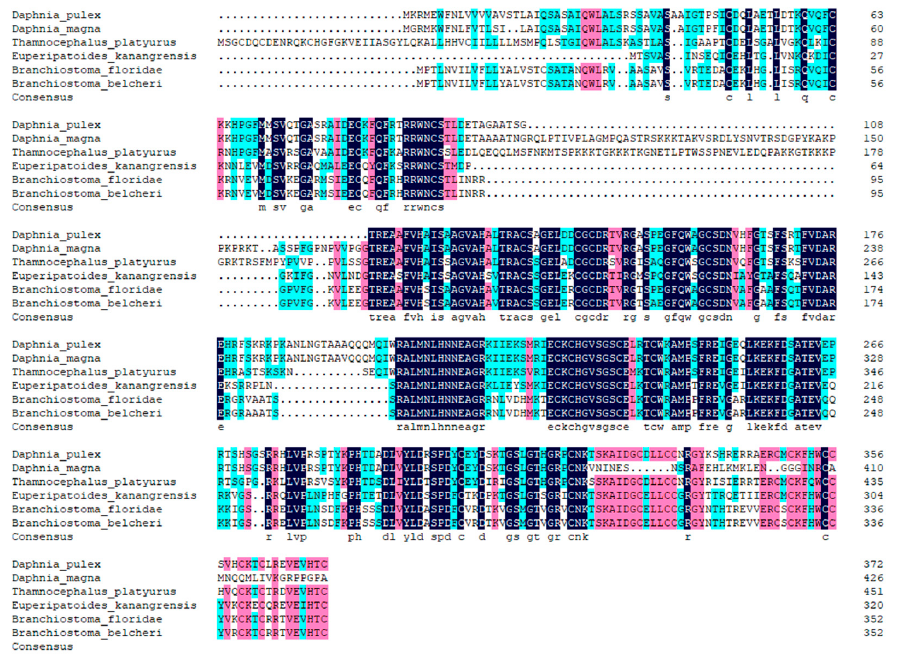
Figure 3. Amino acid sequence alignment of Wnt4 with homologs from other species. All the sequences used in this analysis had the GenBank accession numbers as follows: Daphnia magna (XP_032781217.1), Thamnocephalus platyurus (ALL53302.1), Euperipatoides kanangrensis (CDI40100.1), Branchiostoma floridae (XP_035697471.1), and Branchiostoma belcheri (XP_019642937.1).